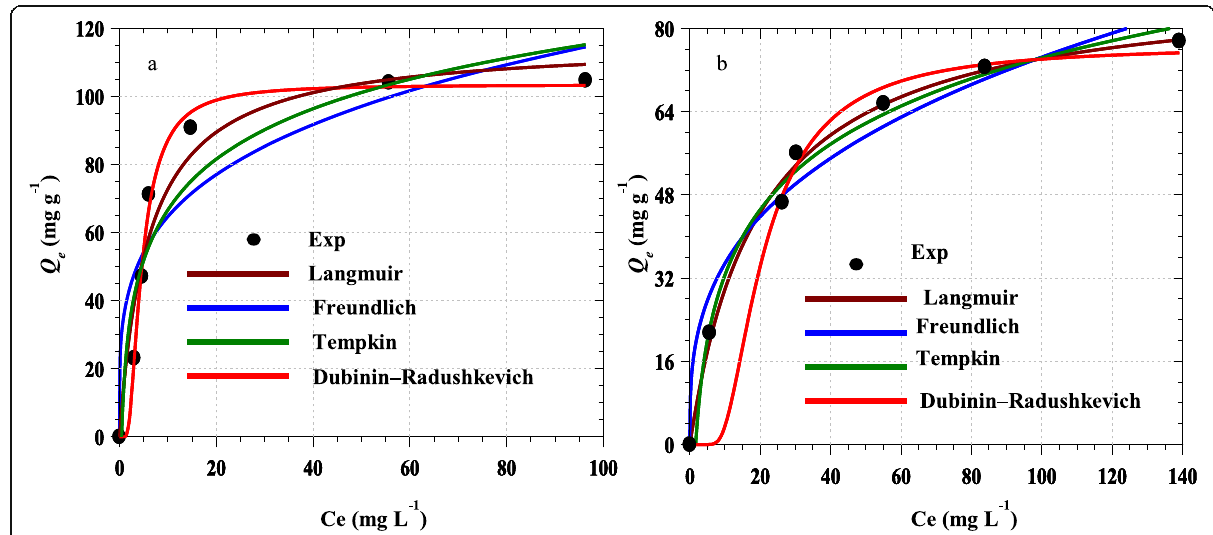
Fig. 11 Isotherm fits for the uptake of a RY4 dye and b Cd(II) onto BMDA (Initial metal/dye conc, 40 – 240 mg L − 1 ; pH, 4.5 and 6.0; BMDA dosage, 0.04 g/L; and Temp, 30